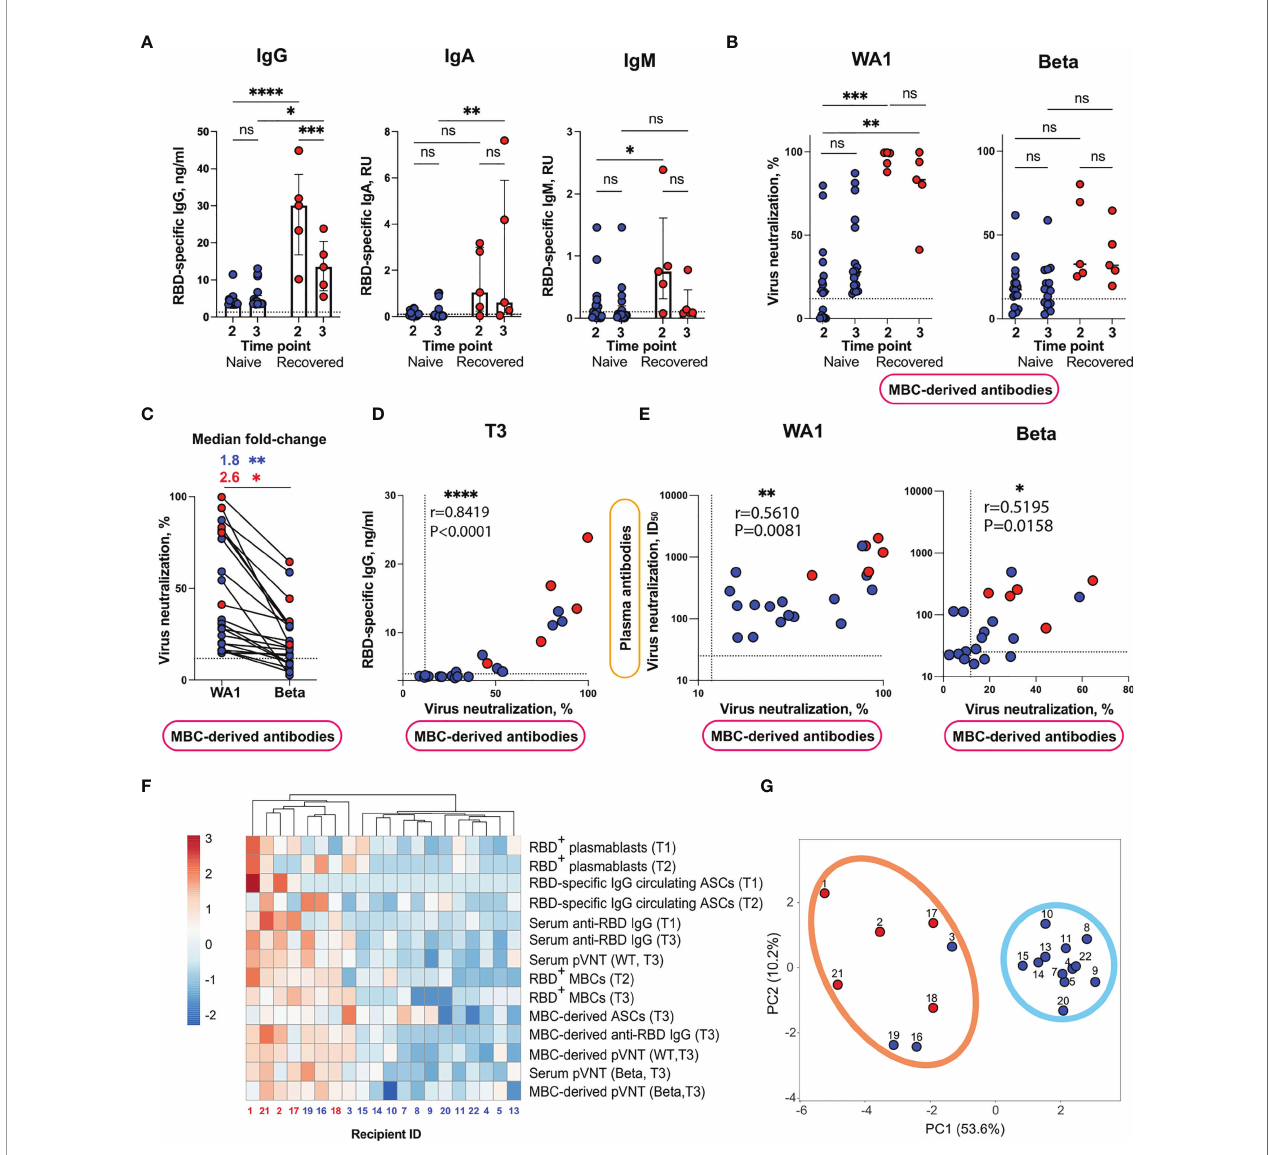
FIGURE 4 | Analysis of MBC-derived antibody response in supernatants of CD40L/IL-21 stimulated B cells from Sputnik V-vaccinated individuals. (A) Production of RBD-speci fi c IgG (left panel), IgA (middle panel) or IgM (right panel) in cultures of IL-21/CD40L-stimulated B cells from Sputnik V-vaccinated individuals evaluated using ELISA. (B) Virus-neutralizing activity of MBC-derived antibodies against WA1 strain (left panel) and Beta variant (right panel) at T2 and T3 time points. (C) Paired analysis of virus-neutralizing activity of MBC-derived antibodies against WA1 strain and Beta variant at T3 time point. (D) Spearman ’ s correlation between virus neutralization (%) and the levels of anti-RBD IgG in supernatants of IL-21/CD40L-stimulated B cells obtained from Sputnik V-vaccinated individuals at T3 time point. (E) Spearman ’ s correlation between the virus-neutralizing activity of plasma and MBC-derived antibodies. Each symbol represents half-maximal inhibitory plasma dilution (ID 50 ) values and % of virus neutralization by supernatant of IL-21/CD40L-stimulated B cells. (F) Heatmap and hierarchical clustering of Sputnik V recipients. Columns denote Sputnik V recipients. Rows correspond to immune response variables. Dendrograms on the top illustrate the clustering of Sputnik V recipients. Immune response measurement values are color-coded according to the key shown in the upper left. (G) Principal component analysis of Sputnik V recipients. Recipient IDs are shown. Two distinct clusters are indicated by the ovals. Results are shown for individual samples (symbols) from naïve (n = 17) and recovered (n = 5) recipients. Data are presented as median ± IQR. Asterisks indicate signi fi cant difference between groups determined using the Kruskal – Wallis test, statistics in (C) panel were calculated using Mann-Whitney test. *P < 0.05, **P < 0.01, ***P < 0.001, ****P < 0.0001, ns, not signi fi cant. IQR, interquartile range; RBD, receptor-binding